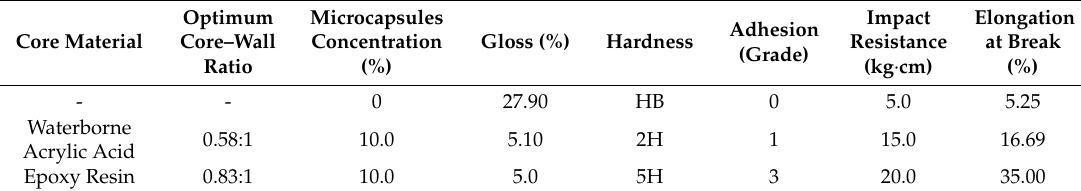
Table 9. Performance comparison of waterborne coatings before and after adding microcapsules.